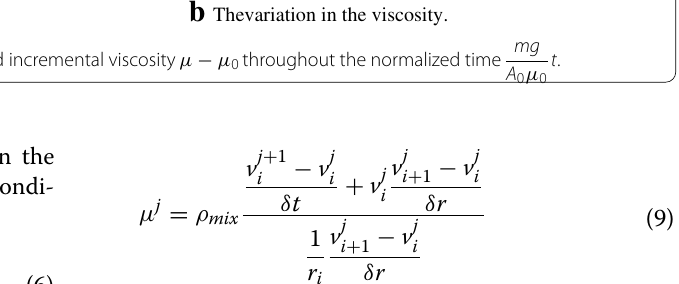
b Thevariation in the viscosity.